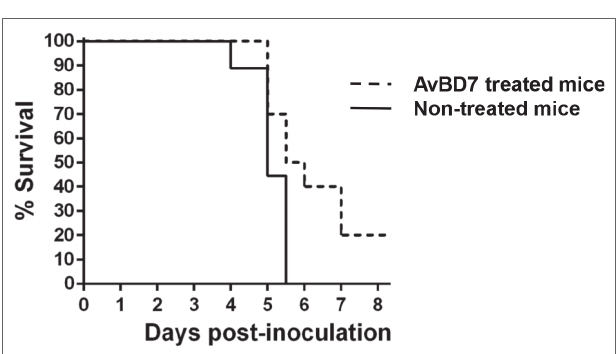
FIGURE 7 | Kinetics of mice survival after inoculation of S . Typhimurium and two injections of 100 μg of AvBD7. BALB/c mice were inoculated by the intraperitoneal route with 140 CFU of S. Typhimurium DT104 strain, and were injected twice over 2 h interval by the same route with 100 μl sterile endotoxin-free H 2 O containing 100 μg AvBD7 (200 μg total per treated animal; dotted line) or not (untreated; full line). Log-rank test indicated significant differences between treated ( n = 10) and mock-treated ( n = 10) group of mice ( p =